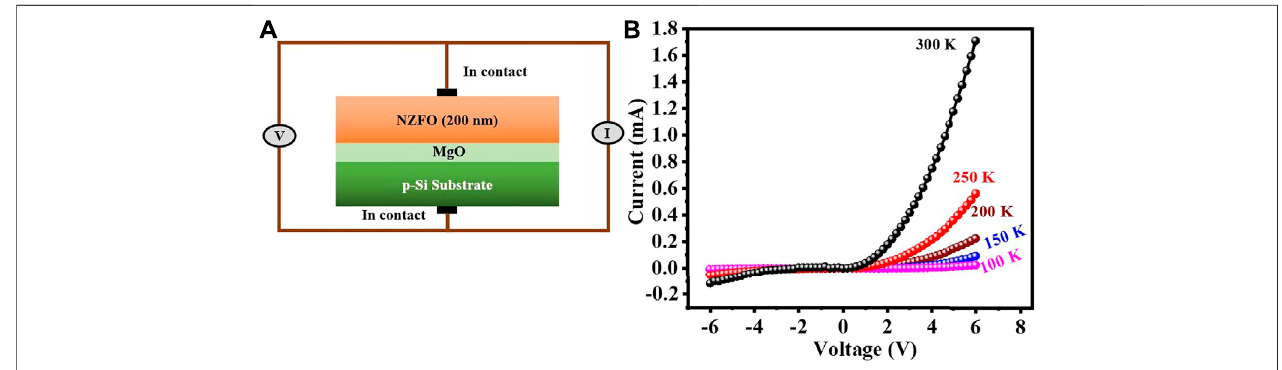
FIGURE 4 | (A) Schematic device geometry for recording I-V data for the NZFO/MgO/p-Si heterojunction. (B) I-V curve of the heterojunction measured in the temperature regime of 100 – 300 K.